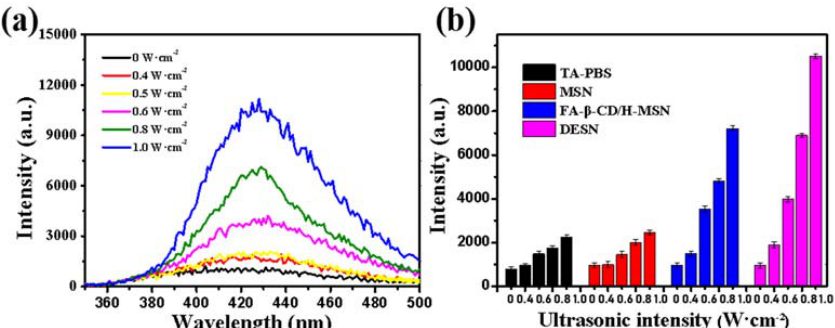
Figure 3. ( a ) Fluorescence assay of the cavitation effect in dispersions of DESN in PBS after ultrasound irradiation for 2 min (1 MHz; 0, 0.4, 0.6, 0.8, and 1.0 W·cm − 2 ); ( b ) Fluorescence assay of the cavitation effect in dispersions of no nanoagents, MSN, FA- β -CD/H-MSN, and DESN in PBS under different ultrasound irradiation intensities ((1 MHz; 0, 0.4, 0.6, 0.8, and 1.0 W·cm − 2 ) for 2 min. The results depicted were represented as means ± SDs ( n = 3).